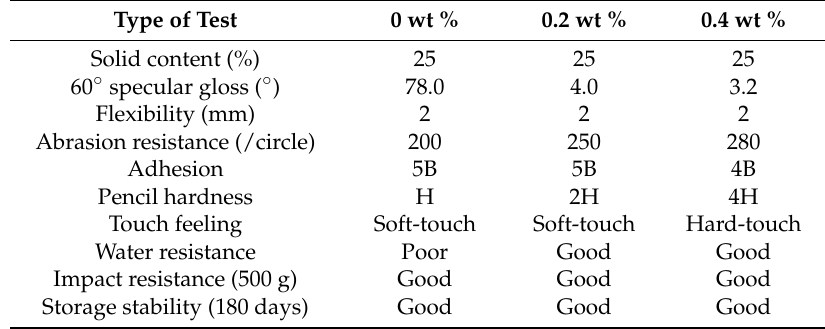
Table 2. Comprehensive properties of the acrylic resin with crosslinker AMA contents ranging from